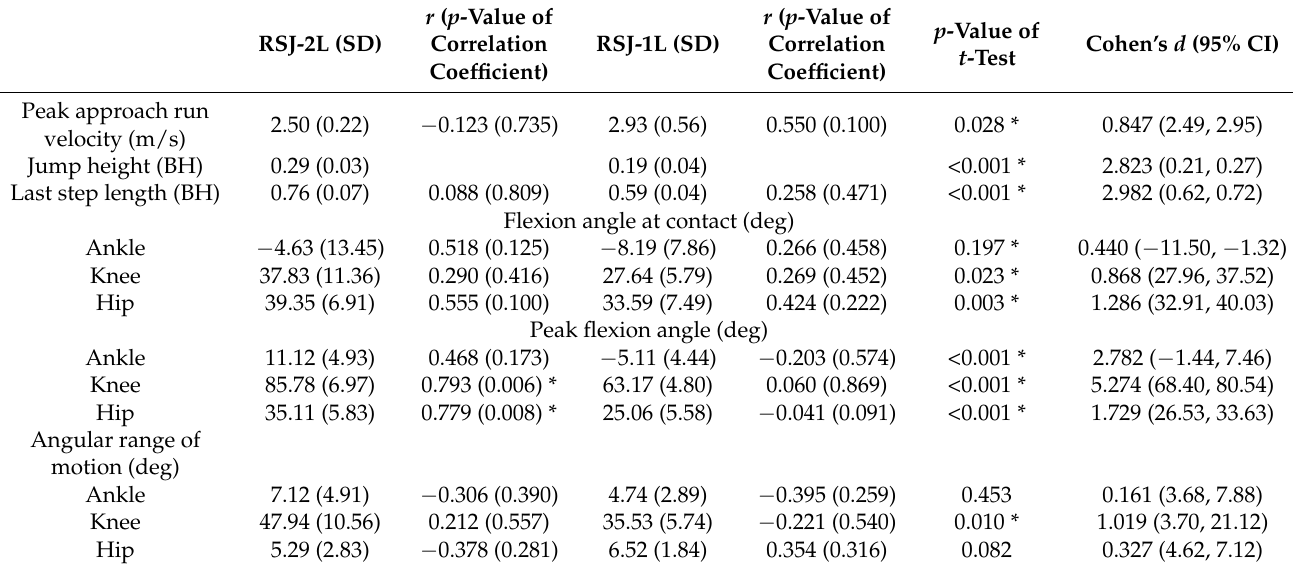
Table 1. The approach run velocity, jump height, last step length, and joint kinematic variables of the left leg and their correlation with the jump height during the spike jumps. r ( p -Value of r ( p -Value of RSJ-2L (SD) Correlation RSJ-1L (SD) Coefficient)